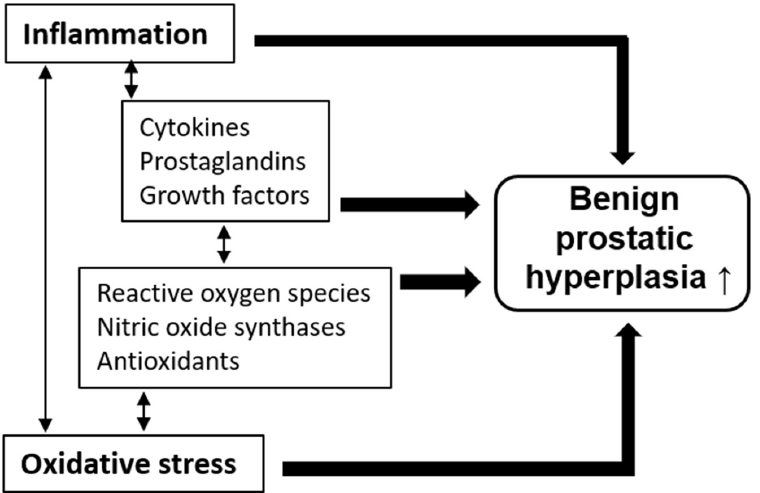
Figure 1. Pathological mechanisms of benign prostatic hyperplasia (BPH) development via inflam- mation and oxidative stress.